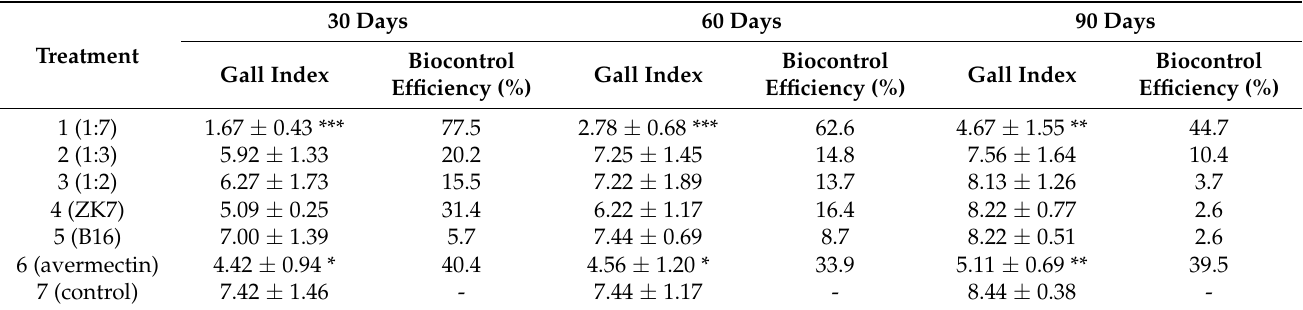
Table 1. Effect of different treatments on galls and biocontrol efficiency in roots of tomato (conducted in field